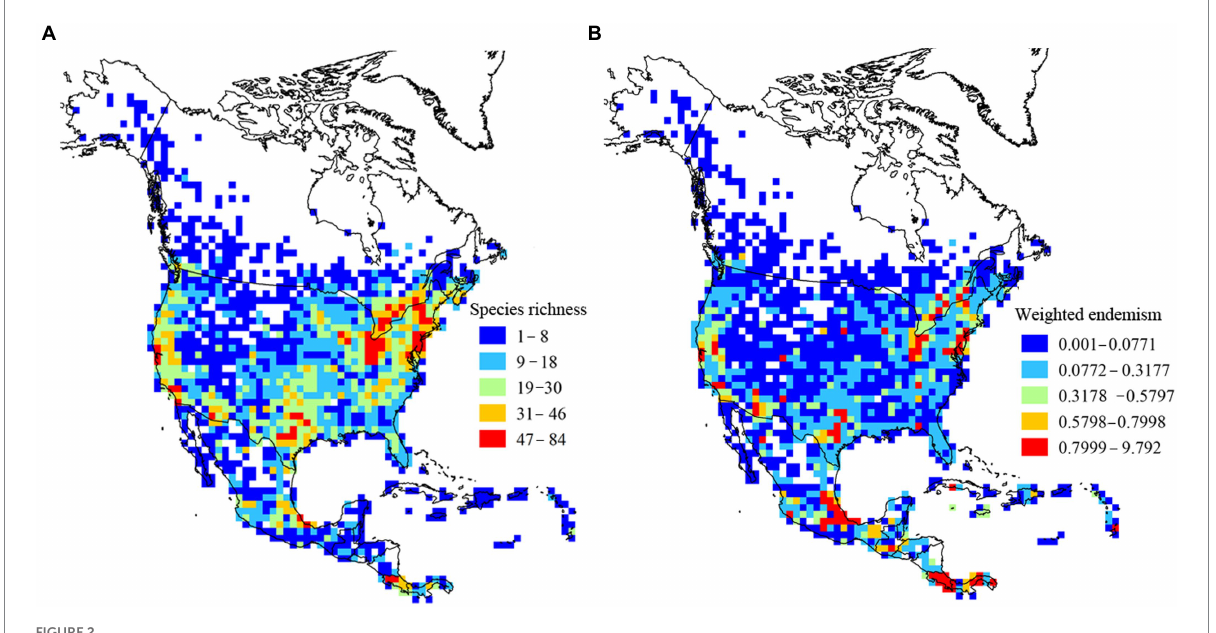
FIGURE 2 Patterns of species richness and weighted endemism in a 100 × 100-km grid size.